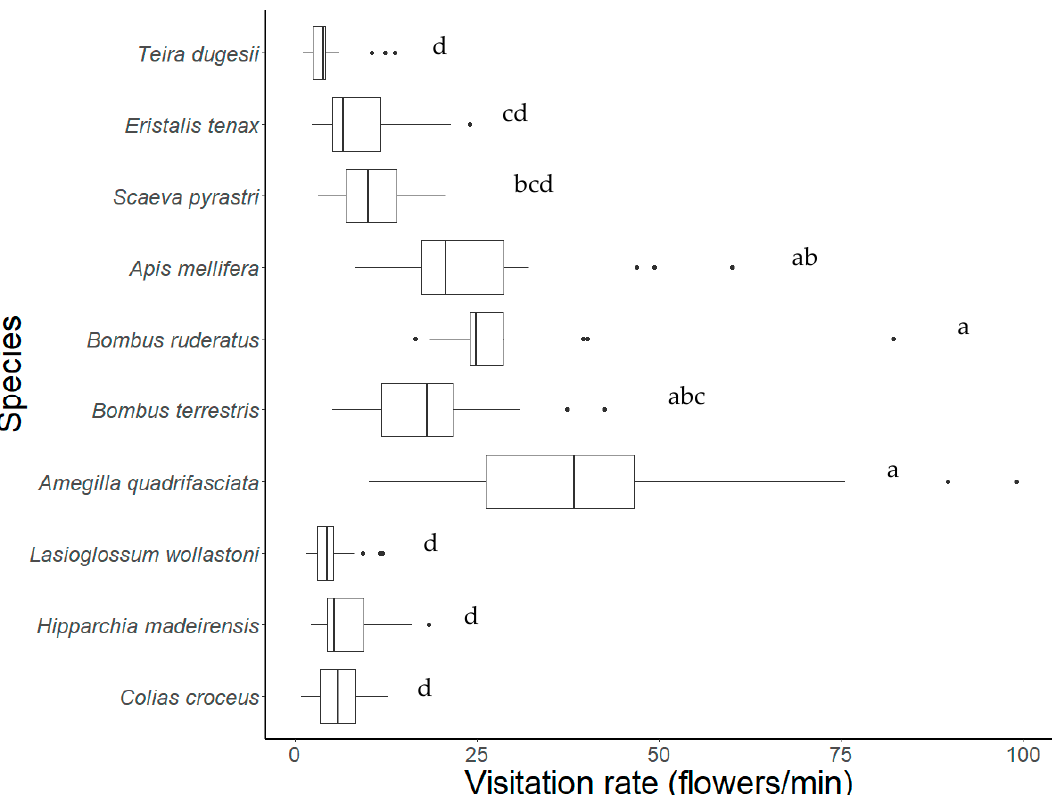
Figure 2. Visitation rates of the most common flower visitors of E. candicans . Twenty individuals/species were sampled except for L. wollastoni ( n = 18). Data are presented as boxplots with descriptive values (minimum, first quartile, median, third quartile, maximum) and outliers. Letters designate groups of species that are statistically similar ( p < 0.05). Visitors belong to four animal groups: butterflies, bees, hoverflies, and the lizard.